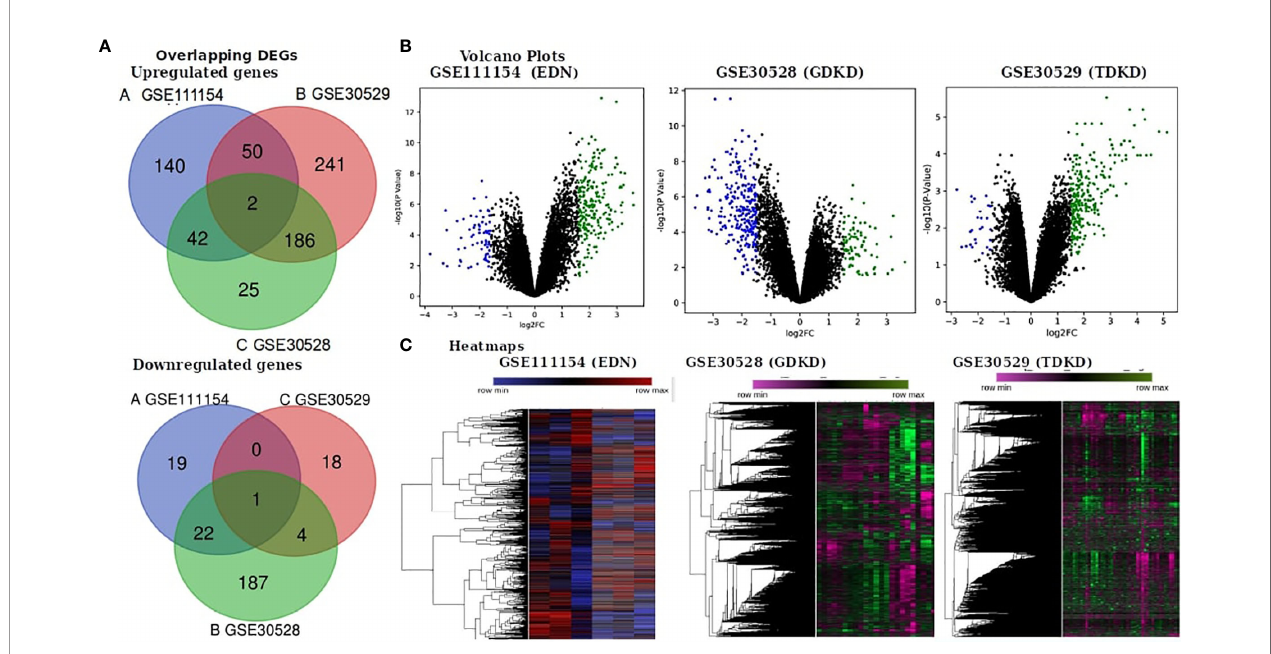
FIGURE 1 | Identi fi cation of differentially expressed genes (DEGs) in the three datasets (EDN: GSE111154, GDKD: GSE30528 and TDKD: GSE30529). (A) Venn diagrams representing commonly changed DEGs in the three datasets. (B) Respective volcano plot of the three datasets. Red and blue plots represent up- and downregulated genes, respectively (log2FC > 1.5 and P value < 0.05). Black plots represent the remaining genes with no signi fi cant difference. (C) Heatmap of the top 500 DEGs are shown.